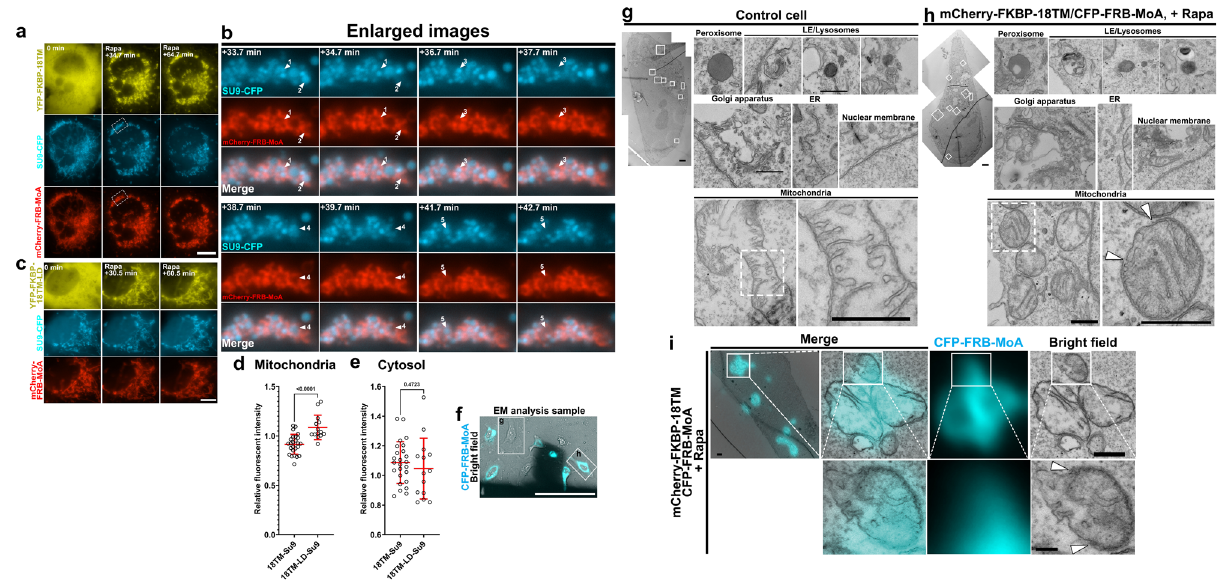
Fig. 4 | Leakage of luminal proteins following 18TM-mediated mitochondrial deformation. a – c Time-lapse fl uorescence images of mCherry-FRB-MoA and Su9- CFP (a mitochondria matrix marker), along with either YFP-FKBP-18TM ( a ) or YFP- FKBP-18TM-LD ( b ), in COS-7 cells before and after treatment with 100nM rapa- mycin. Images indicated by dotted white squares in a are magni fi ed in b . The experiments were repeated at least three times. Scale bar, 10 μ m. d Fluorescence intensity of CFP-Su9 at the deformed mitochondria at 30min after recruitment of 18TM/18TM-LD divided by the intensity at 120min. We intentionally avoided characterizing the fi rst 30min during which mitochondria undergo striking mor- phologicalchanges, preventing accurate measurementofthe fl uorescence signals. The calculated ratio intensity indicates modest decrease over the 90min of 18TM recruitment, which was signi fi cantly different from the corresponding value obtained with 18TM-LD. e Fluorescence intensity of CFP-Su9 in the cytosol was quanti fi ed at 30 and 120min after recruitment of 18TM/18TM-LD. The calculated ratiointensityindicatesthatthereisnosigni fi cantincreaseupon18TMrecruitment nor difference between 18TM and 18TM-LD. The signal intensities were measured